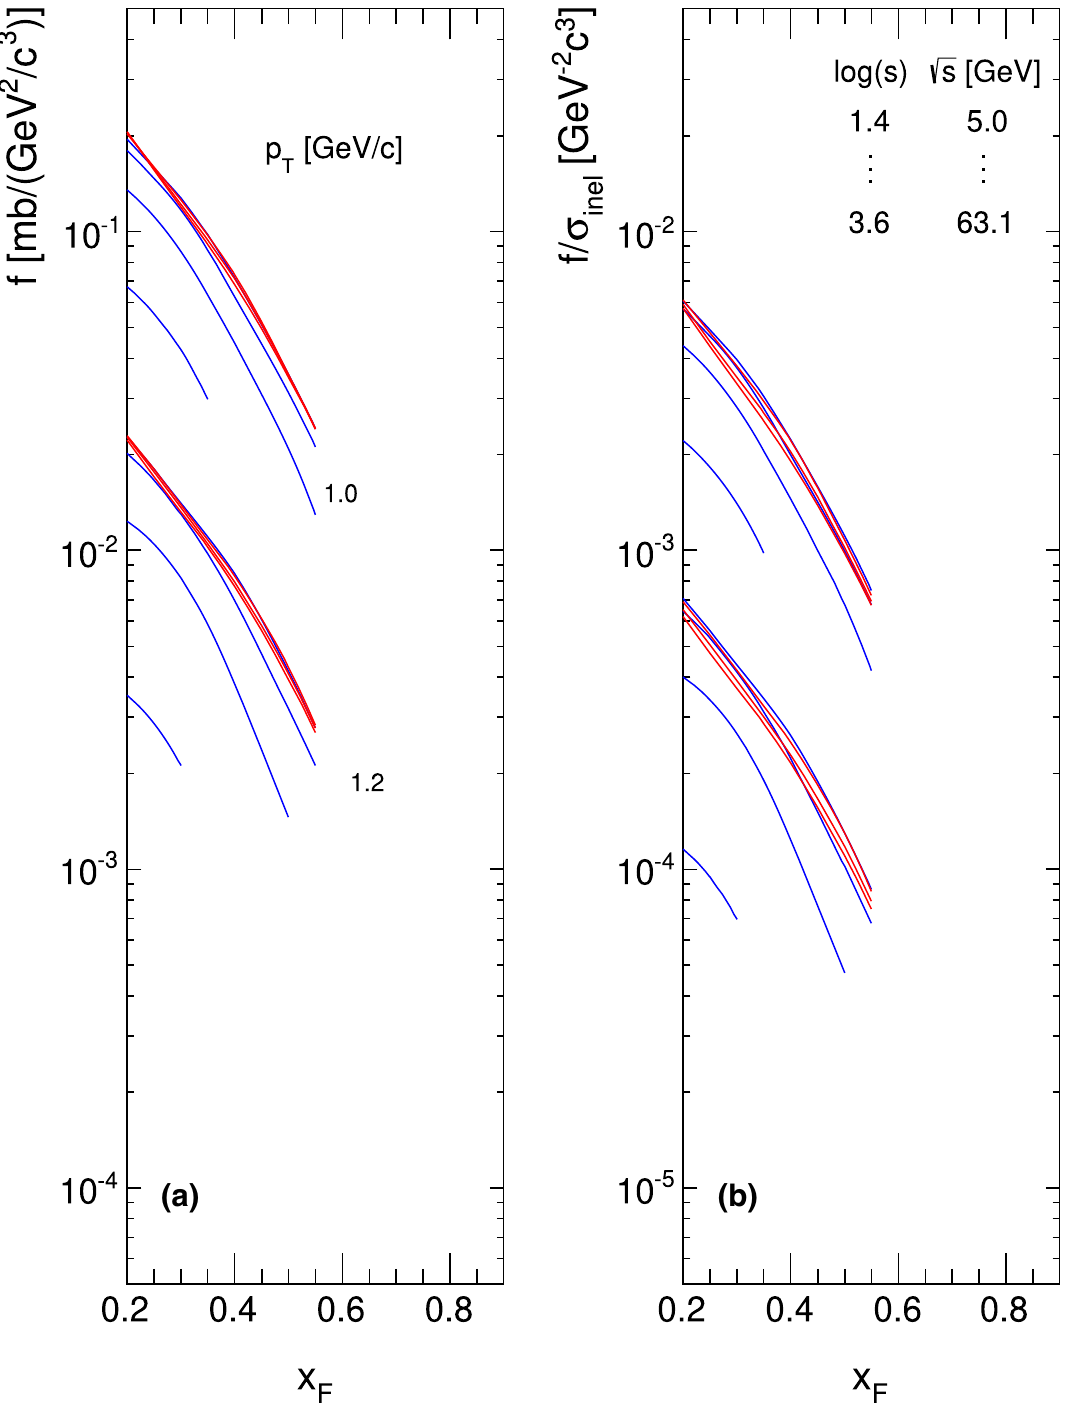
Fig. 114 a f ( x F , p T ) as a function of x F for p T = 1.0 and 1.2 GeV/c for the global interpolation at log ( s ) values from 1.0 to 3.6. The lines at subsequent p T values are scaled down by 1/3 for better separation. b f ( x F , p T )/σ